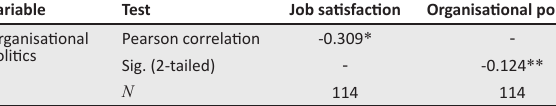
TABLE 2: Relationship between organisational politics and job satisfaction. Variabl